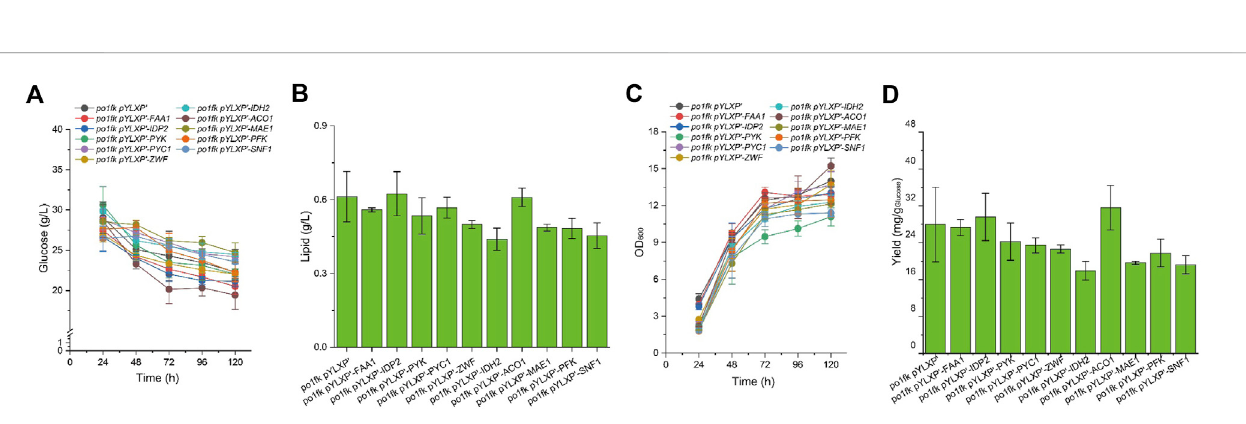
FIGURE 4 Timepro fi lesofcellgrowth,glucoseconsumption,lipidtiterandlipidyieldinCSM-leumedium. (A) Glucoseconsumptionofpo1fkpYLXP ’ ,po1fkpYLXP ’ - ylPYK, po1fk pYLXP ’ -ylACO1,po1fk pYLXP ’ -ylPFK, po1fk pYLXP ’ -ylSNF1, po1fk pYLXP ’ -ylIDP2, po1fk pYLXP ’ -ylZWF, po1fk pYLXP ’ -ylIDH2,po1fk pYLXP ’ -ylMAE, po1fkpYLXP ’ -ylPYC1,andpo1fkpYLXP ’ -ylFAA; (B) Thelipidtiterofpo1fkpYLXP ’ ,po1fkpYLXP ’ -ylPYK,po1fkpYLXP ’ -ylACO1,po1fkpYLXP ’ -ylPFK,po1fkpYLXP ’ - ylSNF1, po1fk pYLXP ’ -ylIDP2, po1fk pYLXP ’ -ylZWF, po1fk pYLXP ’ -ylIDH2, po1fk pYLXP ’ -ylMAE, po1fk pYLXP ’ -ylPYC1, and po1fk pYLXP ’ -ylFAA; (C) Cell growth of po1fk pYLXP ’ , po1fk pYLXP ’ -ylPYK, po1fk pYLXP ’ -ylACO1, po1fk pYLXP ’ -ylPFK, po1fk pYLXP ’ -ylSNF1, po1fk pYLXP ’ -ylIDP2, po1fk pYLXP ’ -ylZWF, po1fk pYLXP ’ -ylIDH2, po1fk pYLXP ’ -ylMAE, po1fk pYLXP ’ -ylPYC1, and po1fk pYLXP ’ -ylFAA; (D) Lipid yield of po1fk pYLXP ’ , po1fk pYLXP ’ -ylPYK, po1fk pYLXP ’ - ylACO1, po1fk pYLXP ’ -ylPFK, po1fk pYLXP ’ -ylSNF1, po1fk pYLXP ’ -ylIDP2, po1fk pYLXP ’ -ylZWF, po1fk pYLXP ’ -ylIDH2, po1fk pYLXP ’ -ylMAE, po1fk pYLXP ’ - ylPYC1, and po1fk pYLXP ’